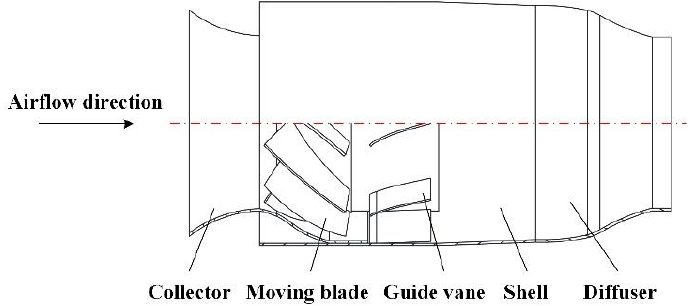
Figure 1. Physical model of small diagonal flow fan.